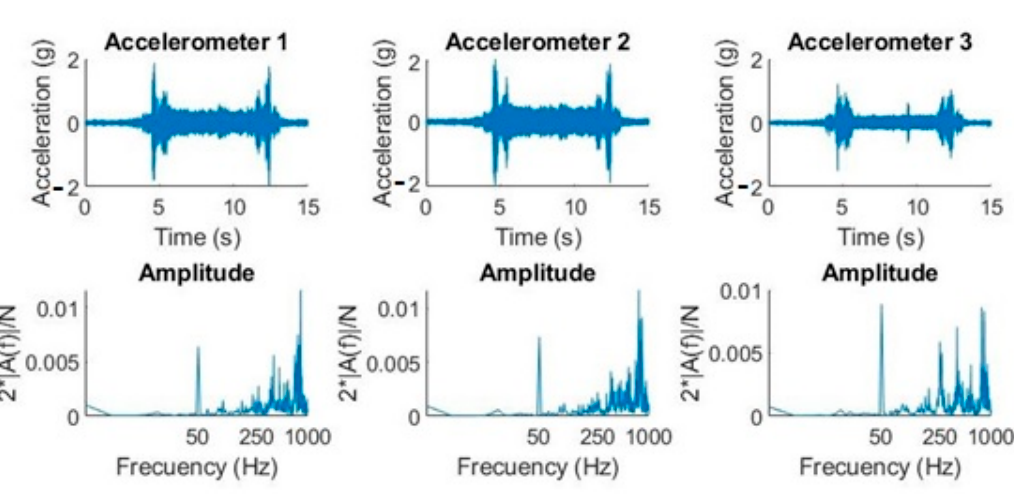
Figure 10. DC removal effect on a real signal (declination movement from 40° to 0°). The red line in the graphs establishes the maximum value of the displacement.